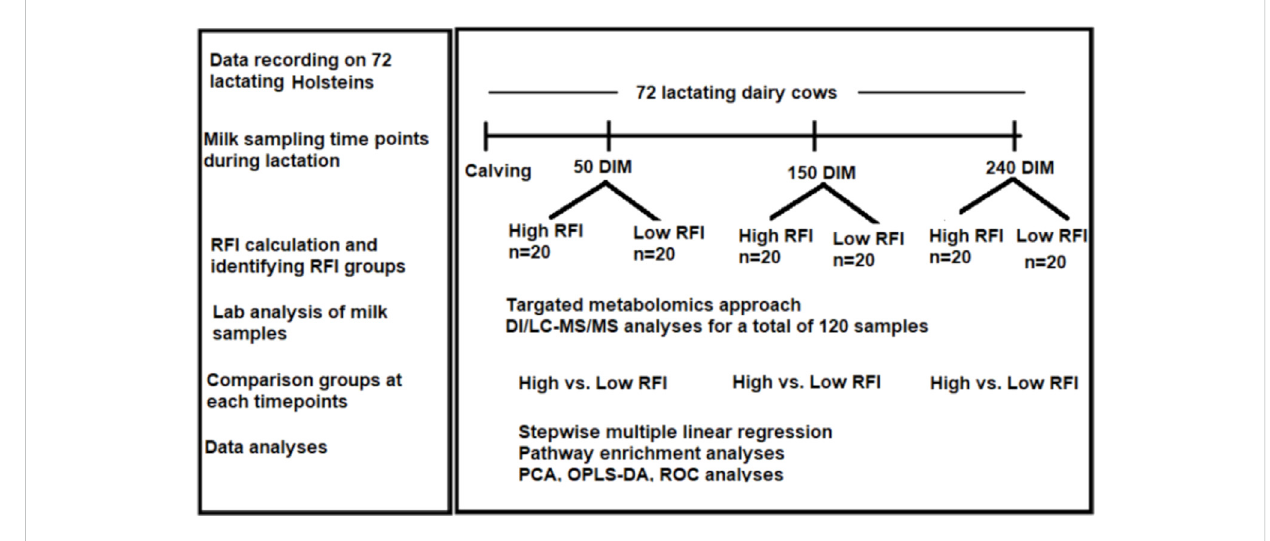
FIGURE 1 Work fl ow of the study showing calculation of RFI in 72 cows from 3 – 240 DIM and milk samples collection at three time points (50, 150, 240 DIM) duringlactation.CowswererankedandthehighandlowRFIgroupswereidenti fi ed.MilksamplesfromhighandlowRFIgroupsinallthethreetimepoints were analyzed using DI/LC-MS/MS method.